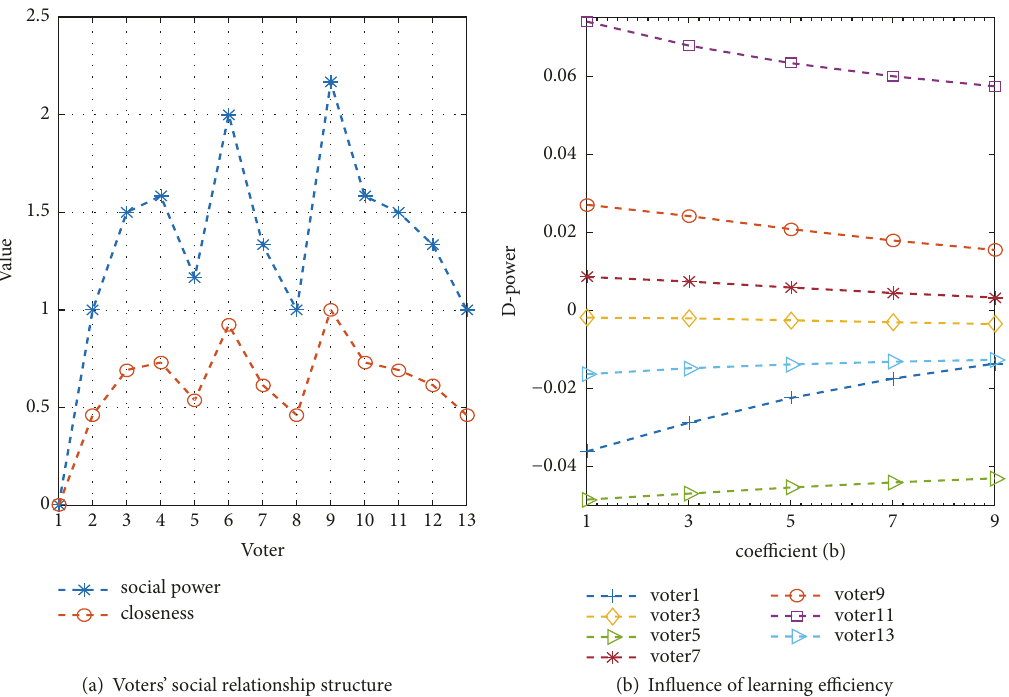
Figure 13: Impact of social learning efficiency and social relationship structure. Voters play a voting game in a social network with 13 players and a 30% random connection probability. Subgraph (a) shows the simulation results of voters’ social power and relationship closeness with neighbors.Subgraph (b) shows the simulation results of changes in power indices ( 𝐷 - 𝑝𝑜𝑤𝑒𝑟(𝑖) = 𝑅 󸀠 (𝑖)−𝐵 󸀠 (𝑖) ), in whichvoters play a repeated voting game with the social learning efficiency ( 𝑏 ) increasing from 𝑏 = 1 to 𝑏 = 9 while leaving other parameters unchanged. The integrated power of voters with higher social impact or closeness decreases accompanied by the increases of social learning efficiency ( 𝑏 ), and the voters with lower social impact or closeness are the opposite, while both cases are possible for the voters with middle social impact or